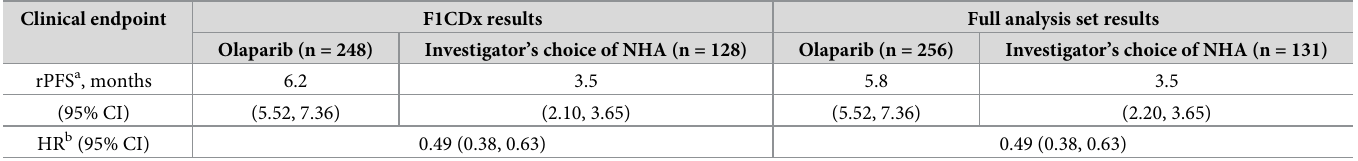
Table 6. Clinical utility of F1CDx for HRR mutations companion diagnostic claims in the combined Cohort A and Cohort